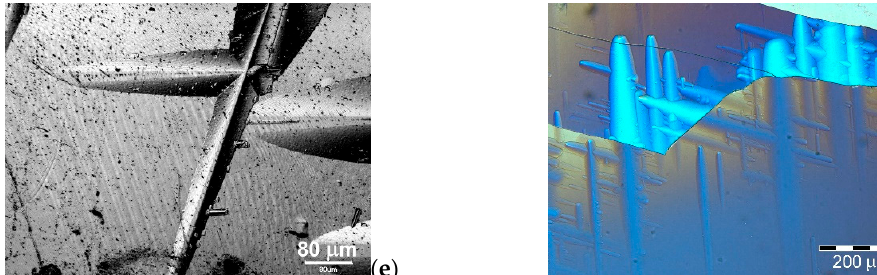
Figure 2. p-Quinquephenyl crystals grown from solution: ( a ) a group of crystals under the UV light; ( b ) the optical image of a thin single crystal in the transmitted light with the crossed polarizers; ( c ) the optical image of a thickened single crystal in the reflected light, enlarged confocal images (in scanning mode) of the crystal section marked by arrows “1” ( d ) and “2” ( e ) in Figure ( c ); ( f ) the optical image in the reflected light (in deep phase contrast mode) of the dendritic growths network on the crystal surface.